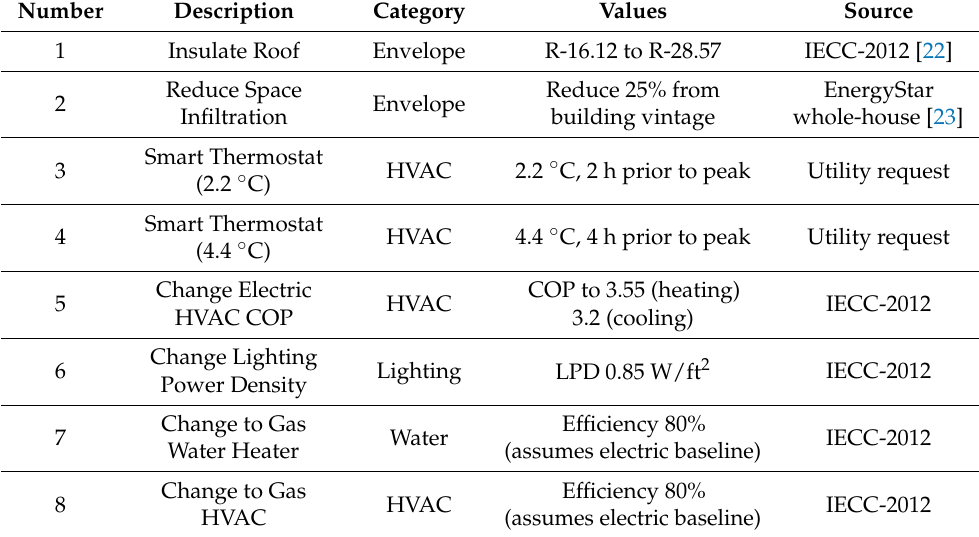
Table 2. Building technologies/controls (measures) simulated in each of the 178,337 building energy models to quantify savings defined in Table 3. Acronyms: IECC (International Energy Conservation Code), HVAC (Heating, Ventilation, and Air